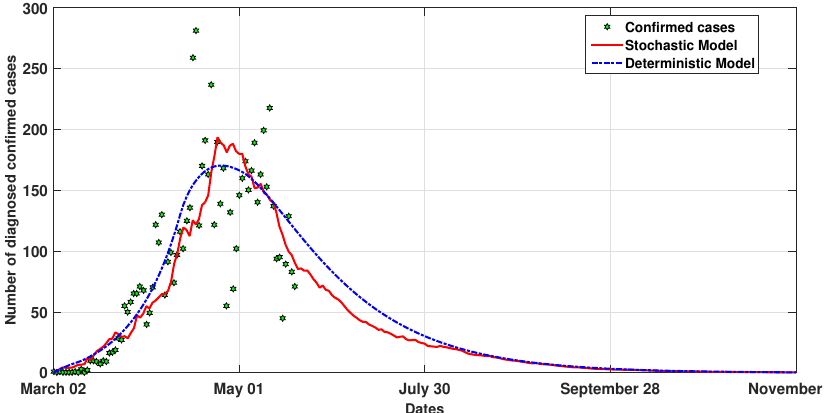
Figure 1. Comparison of the deterministic and the stochastic dynamical behavior with the daily